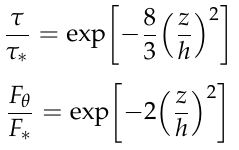
Figure 3. Dependence of the momentum flux on the Reynolds averaging scale 𝐿 used to compute the perturbation quantities for ( a ) stationary and ( b ) nonstationary episodes.